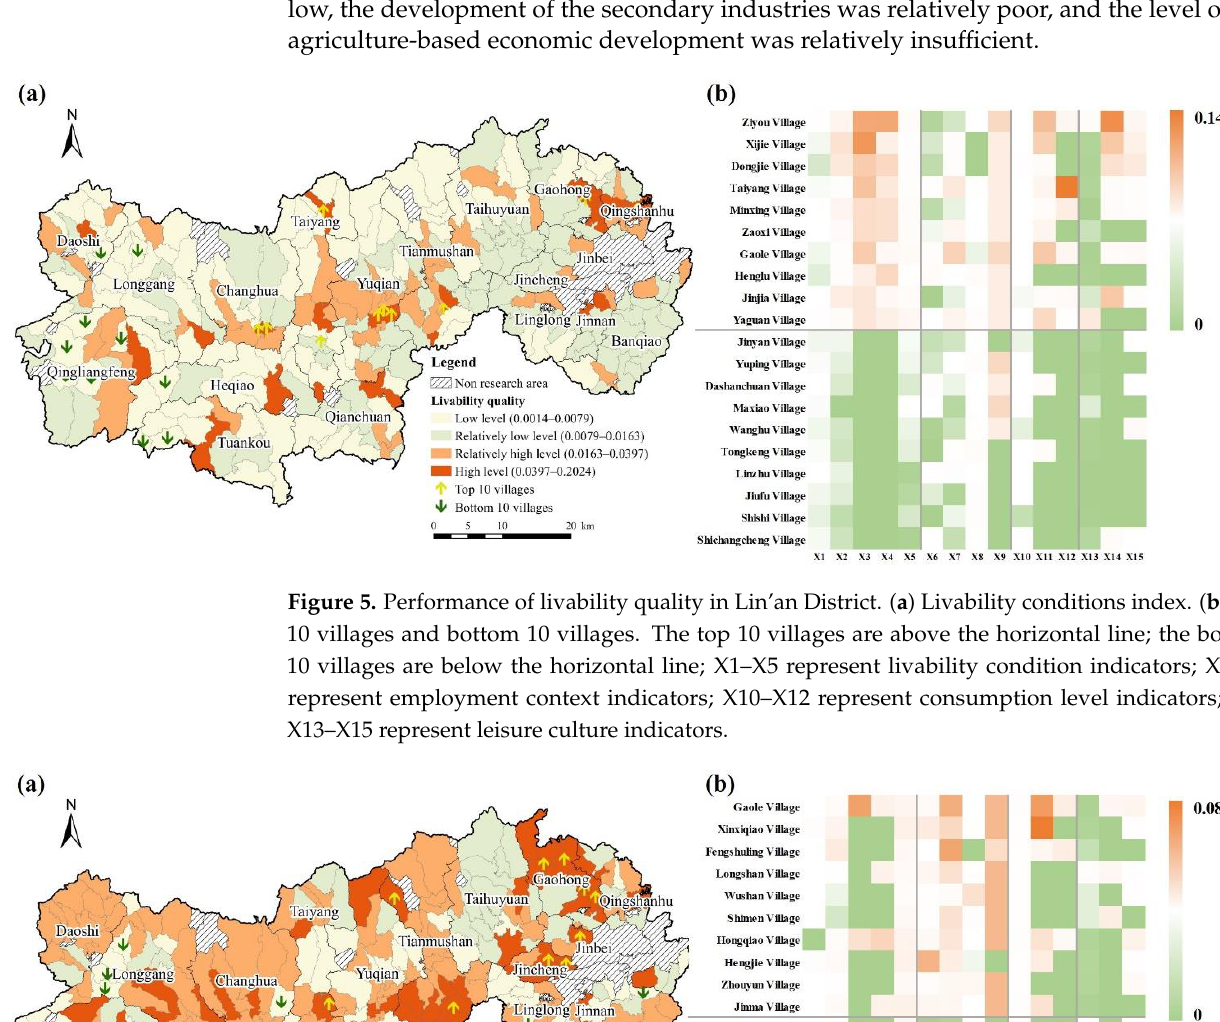
Figure 5. Performance of livability quality in Lin’an District. ( a ) Livability conditions index. ( b ) Top 10 villages and bottom 10 villages. The top 10 villages are above the horizontal line; the bottom 10 villages are below the horizontal line; X1 – X5 represent livability condition indicators; X6 – X9 repre- sent employment context indicators; X10 – X12 represent consumption level indicators; and X13 – X15 represent leisure culture indicators.